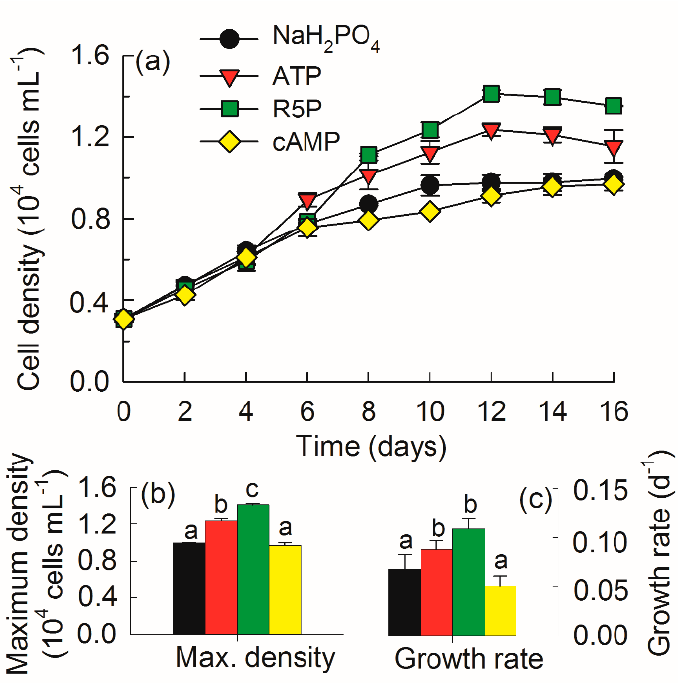
Figure 2. Growth curve ( a ), maximum cell density ( b ), and average growth rate ( µ ) ( c ) of Karenia mikimotoi in the NaH 2 PO 4 , adenosine triphosphate (ATP), ribulose 5-phosphate (R5P), and cyclic adenosine monophosphate (cAMP) treatments. The values are the mean ± S.D. ( n = 3). Significant differences ( p < 0.05) among different phosphorus substrates are shown with different lowercase letters.